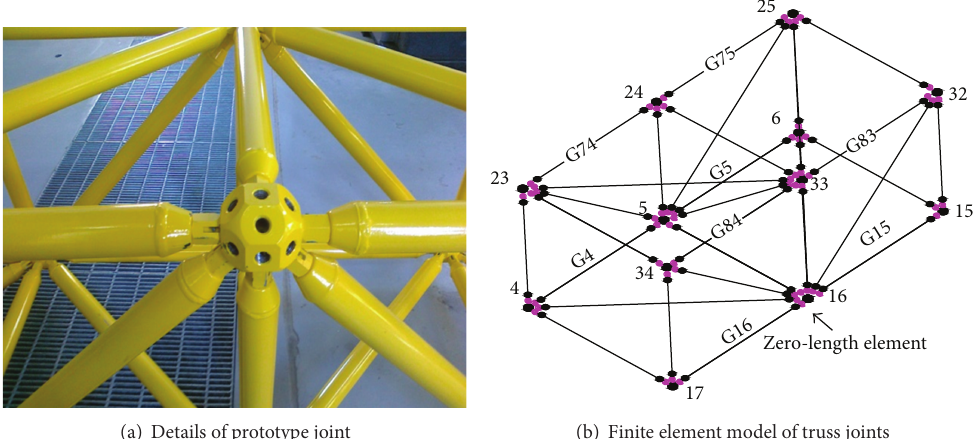
Figure 2: Details of prototype joint and finite element model of truss joints.